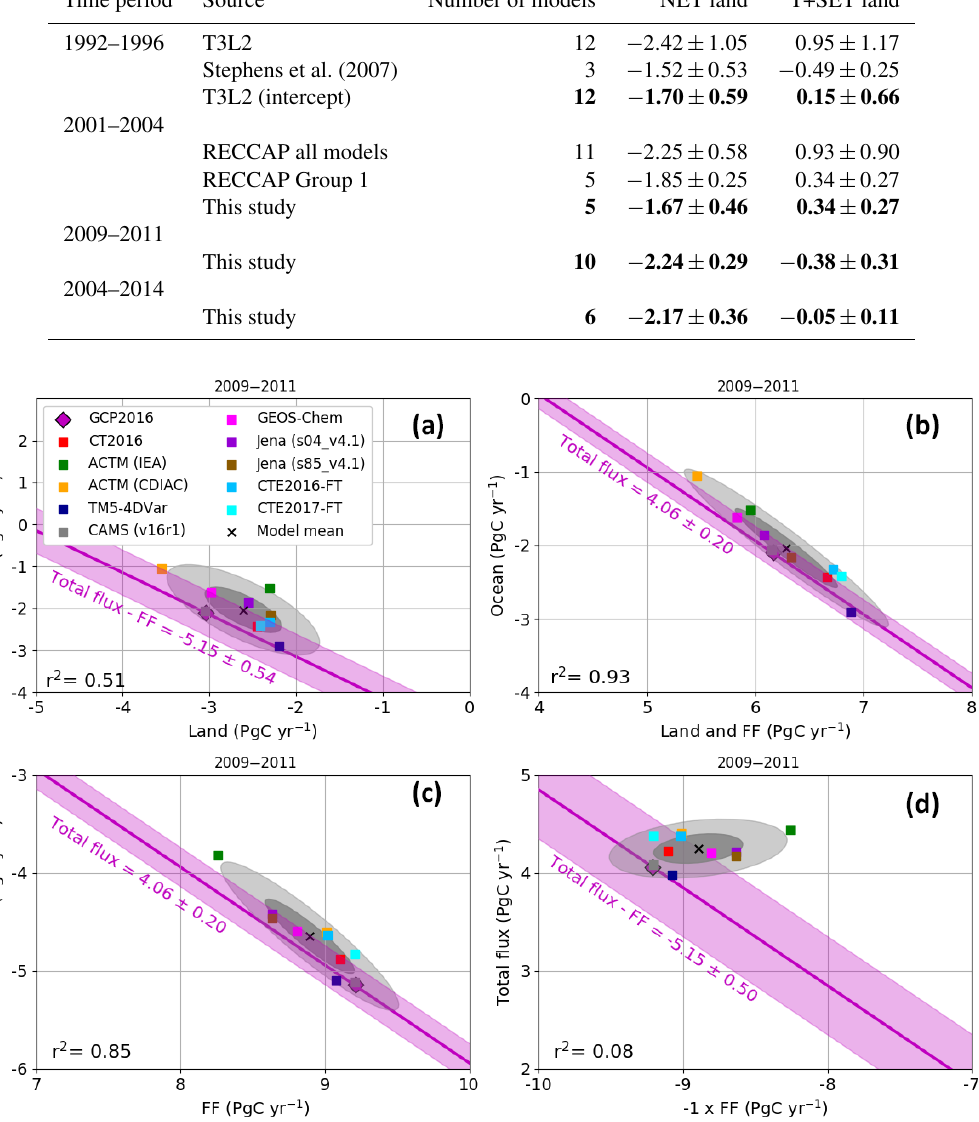
Figure 4. Synthesis of globally integrated fluxes for the 2009–2011 period, in PgCyr − 1 . Each inversion is represented by a square and the model mean by a × symbol. The GCP2016 estimates are a pink diamond, which is sometimes hard to see because it is superimposed in each panel by the gray CAMS point. We have adjusted the GCP2016 ocean and land flux estimates by the riverine flux of carbon from land to ocean to atmosphere (0.45PgCyr − 1 ; Jacobson et al., 2007; Le Quéré et al., 2018), decreasing the ocean sink and increasing the land sink. The magenta line and light-pink shaded area show the corresponding mass balance estimates from GCP2016. In each panel the line and equation shown represent the sum of the x and y variables, and thus the line has a slope of − 1, and any deviation perpendicular to the line indicates disagreement on the sum. Here we use the total flux which by mass balance is the whole-atmosphere growth rate (see text), and for panels (a) and (d) , the total flux – FF line also equals O + L, while for panels (b) and (c) , the total flux line equals O + L + FF. Ellipses denote the variability around the model means of 1 σ (darker gray) and 2 σ (lighter gray). (a) Ocean versus land; (b) ocean versus land + FF; (c) ocean + land versus FF; (d) total flux versus − 1 ×